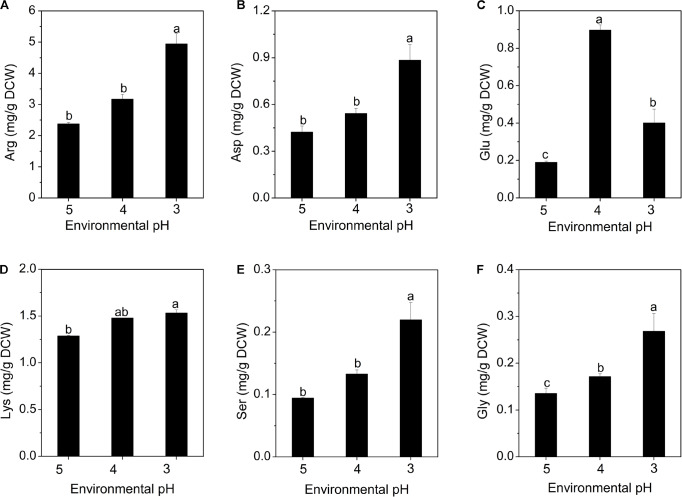
Changes in intracellular amino acid concentrations of S. albulus M-Z18 in batch fermentations at different environmental pH (pH 5.0, 4.0, and 3.0). Arginine (A), aspartate (B), glutamate (C), lysine (D), serine (E), and glycine (F). Samples were collected at 27 h. Statistical significance is denoted by different letter for the same indicator.